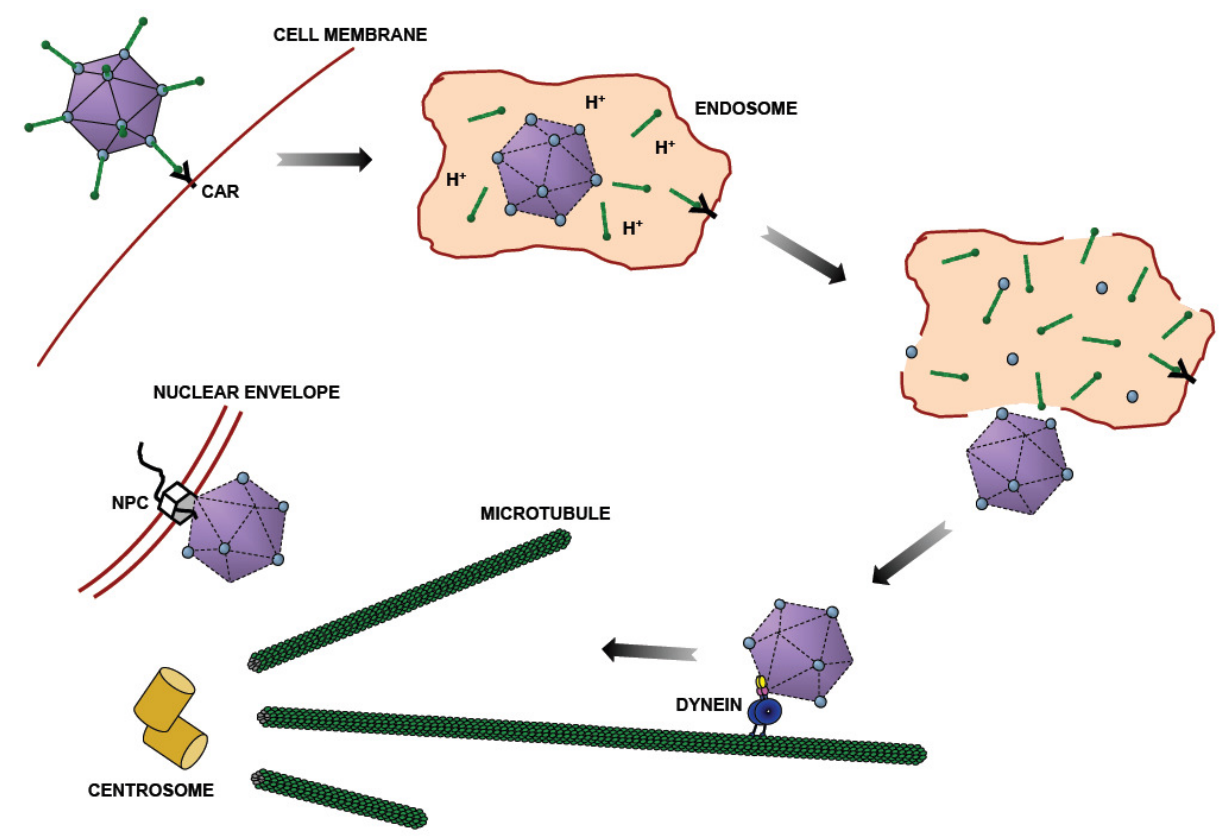
Figure 1. Adenovirus Entry Pathway. After binding to the plasma membrane through the Coxsackie and Adenovirus (CAR) receptor, adenovirus is taken up by endocytosis [8,9]. endosomalysis, adenovirus moves bidirectionally along microtubules (MTs) [13],